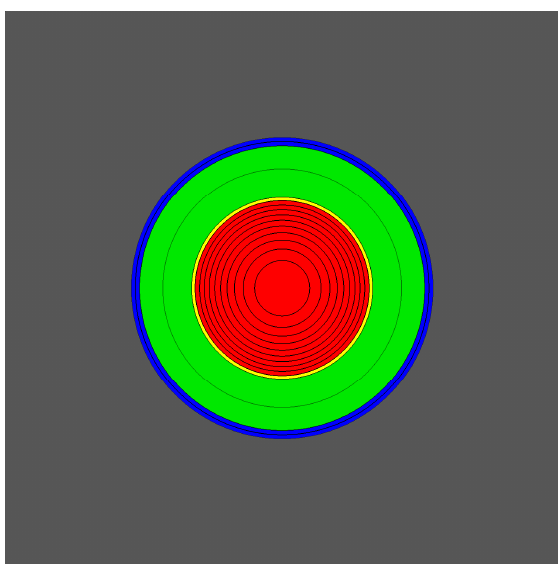
Figure 3. The 2 ‐ D SCALE/POLARIS model (molten salt fuel core—red, stainless steel—yellow, NaCl reflector—light green, vacuum—blue, absorber material—dark grey) used for the general analysis.